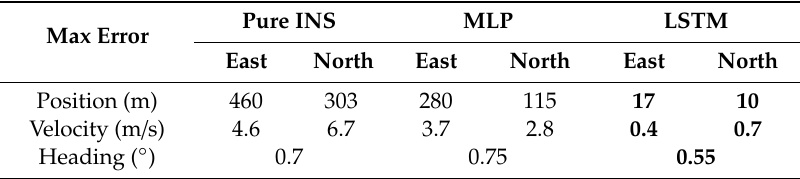
Figure 23. LSTM 180 s outages trajectory. 5.4. Experiment Summary When the GNSS signal is not available, the whole system turns to predicting mode. The measurements from INS—which are the specific force, velocity, yaw, and angular rate—are sent to a well-trained AI-based model so as to attain a predicting value of position increments. Then, accumulating these position increments can get the pseudo-GNSS position to act as a substitute of the true GNSS position, which will subtract the position measurement from INS to constitute a part of the input vector of the Kalman filter. Finally, the Kalman filter will correct the INS errors so as to attain the corrected position, attitude, and velocity. The test results indicate that the MLP algorithm, which suffers from an incapability of dealing with time-dependency between current and past vehicle dynamics, cannot be a proper model for aiding INS during GNSS signal outages. When the GNSS